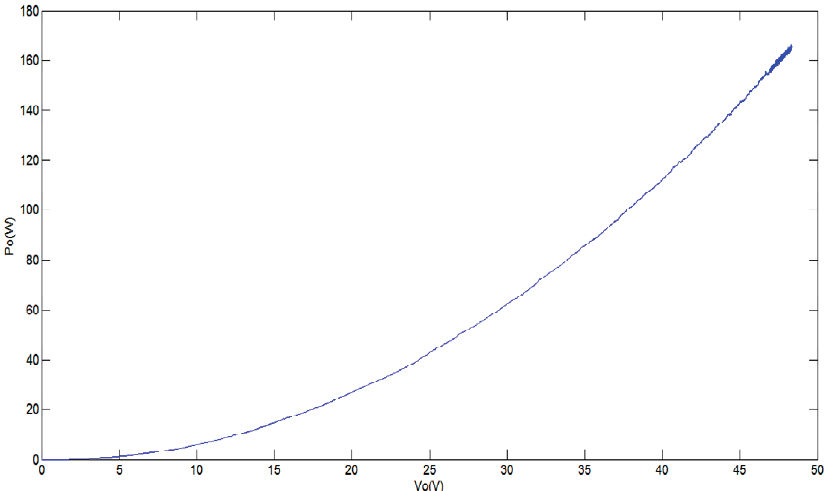
Figure 13. ESMS MPPT P-V characteristics